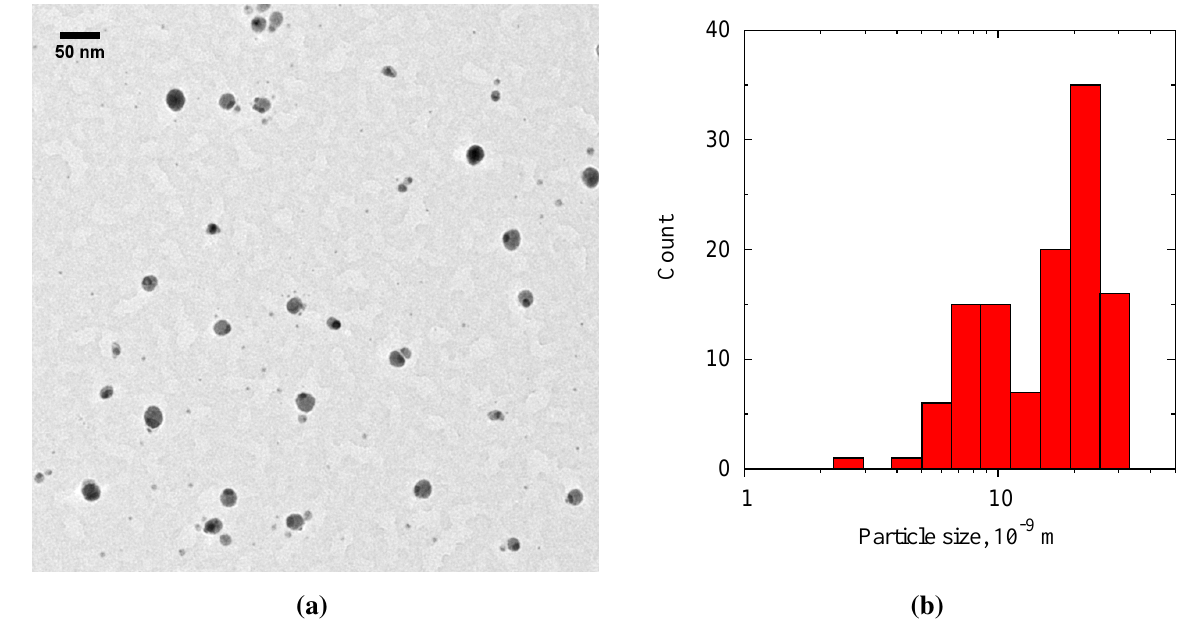
Figure 6. ( a ) TEM micrograph of Au-on-Ag particles with s 50-nm scale bar; ( b ) particle size distribution of 116 particles.